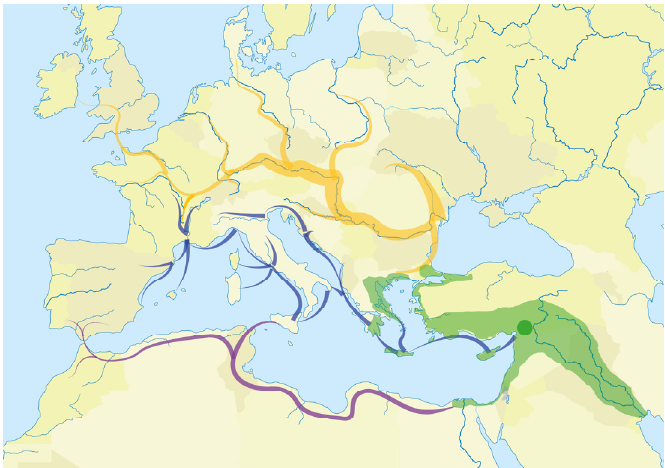
Figure 6. Neolithic migration of domestic cattle in